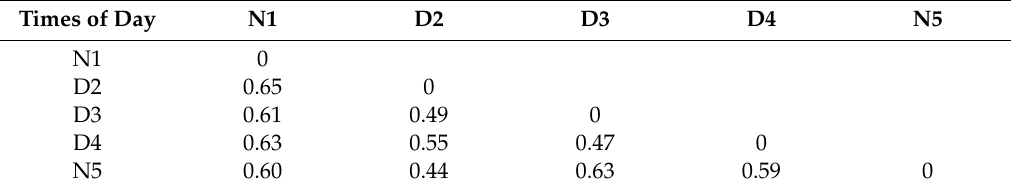
Table 3. The Bray-Curtis dissimilarity index of M . ioensis “Prairie Rose” floral scent during the day and night. Times of Day